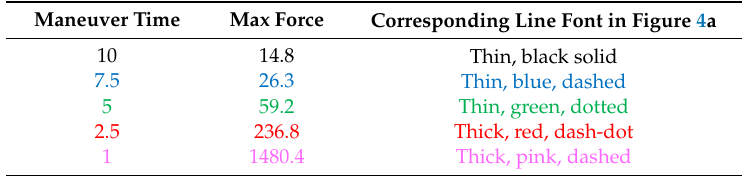
Table 4. Maneuvers and required maximum force corresponding to Figure 12a.